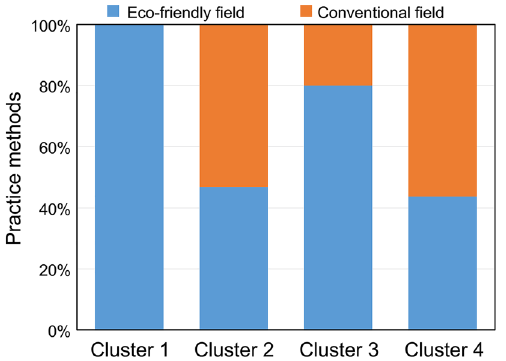
Figure 3. Difference in the practiced method among the four clusters defined by the self-organizing map.